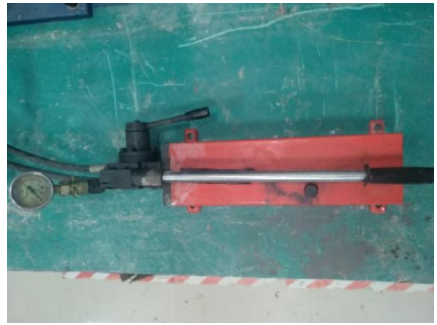
Figure 7. Manual hydraulic oil pump.